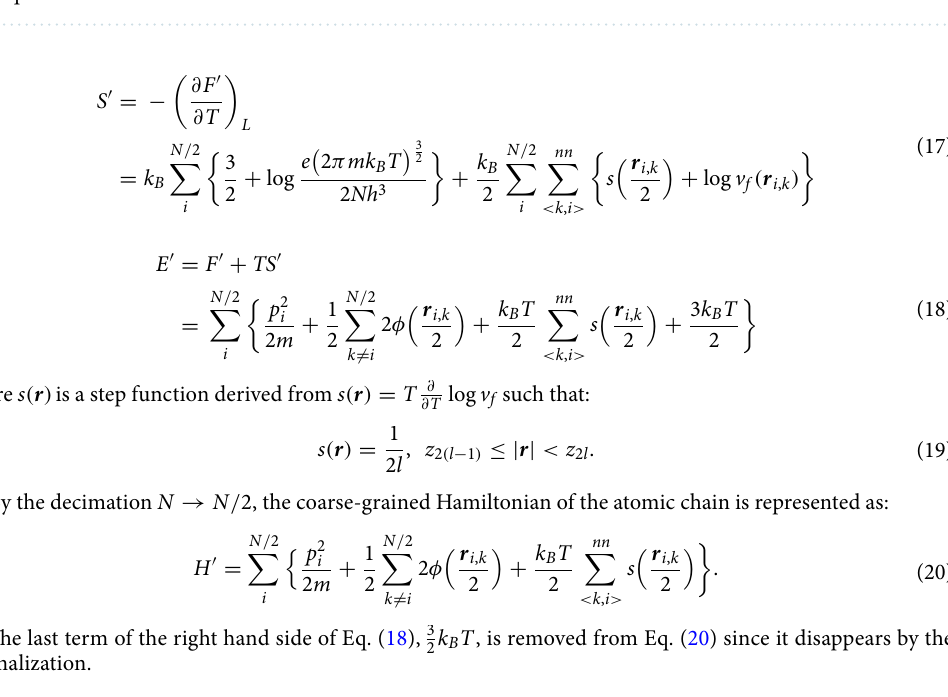
Figure 1. Schematics of the reconstructed interactions of a two-dimensional square lattice by the Migdal– Kadanoff approximation and appearance of atomic chains. Black dot: particles. Solid line: nearest neighbor interactions. Dashed line: interactions to be moved to adjacent interactions. Double line: interactions reconstructed with strength of 2 ǫ . ( a ) A two-dimensional square lattice before the Migdal–Kadanoff approximation. ( b ) The square lattice after the Migdal–Kadanoff approximation. Atomic chains appear in the new square